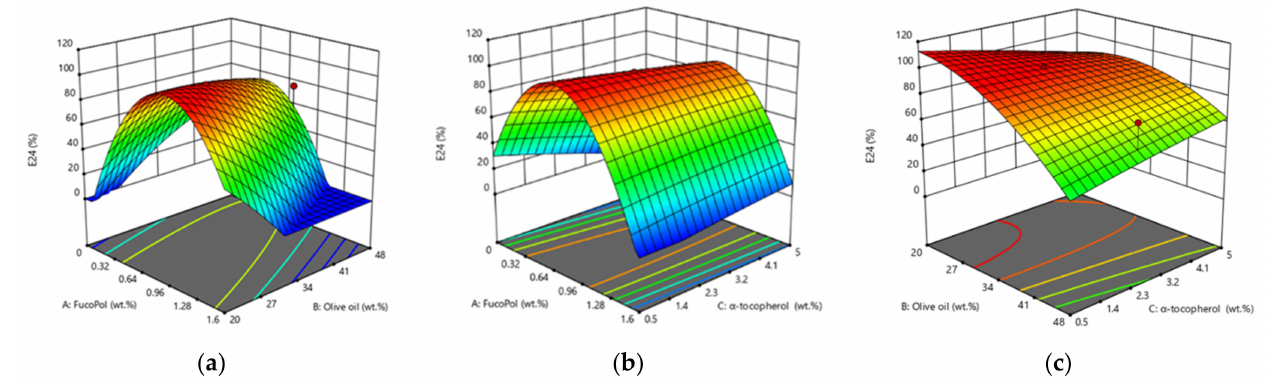
Figure 5. Three-dimensional response surface plot showing the interactive effects of different compo- nents on the O/W emulsion. ( a ) FucoPol and Olive oil (wt.%) with α -tocopherol fixed at 2.5 wt.%, ( b ) FucoPol and α -tocopherol (wt.%) with olive oil fixed at 30 wt.%, ( c ) olive oil and and α -tocopherol (wt.%) with FucoPol fixed at 0.8